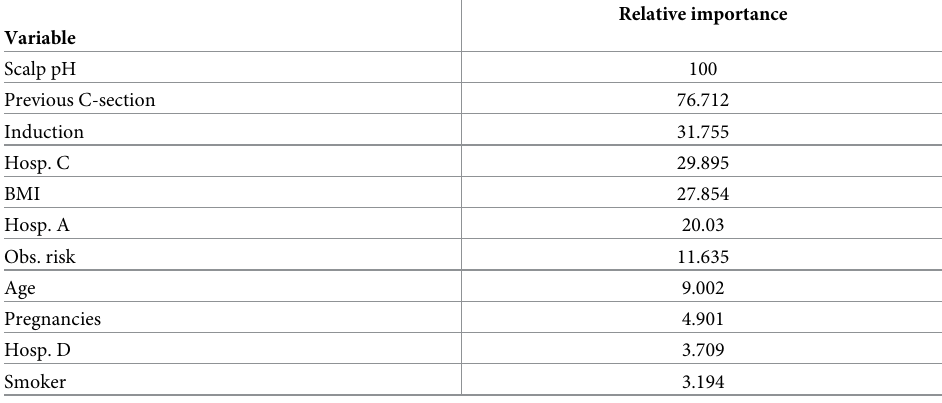
Table 7. Relative importance of each putative risk factor for type of delivery according to the random